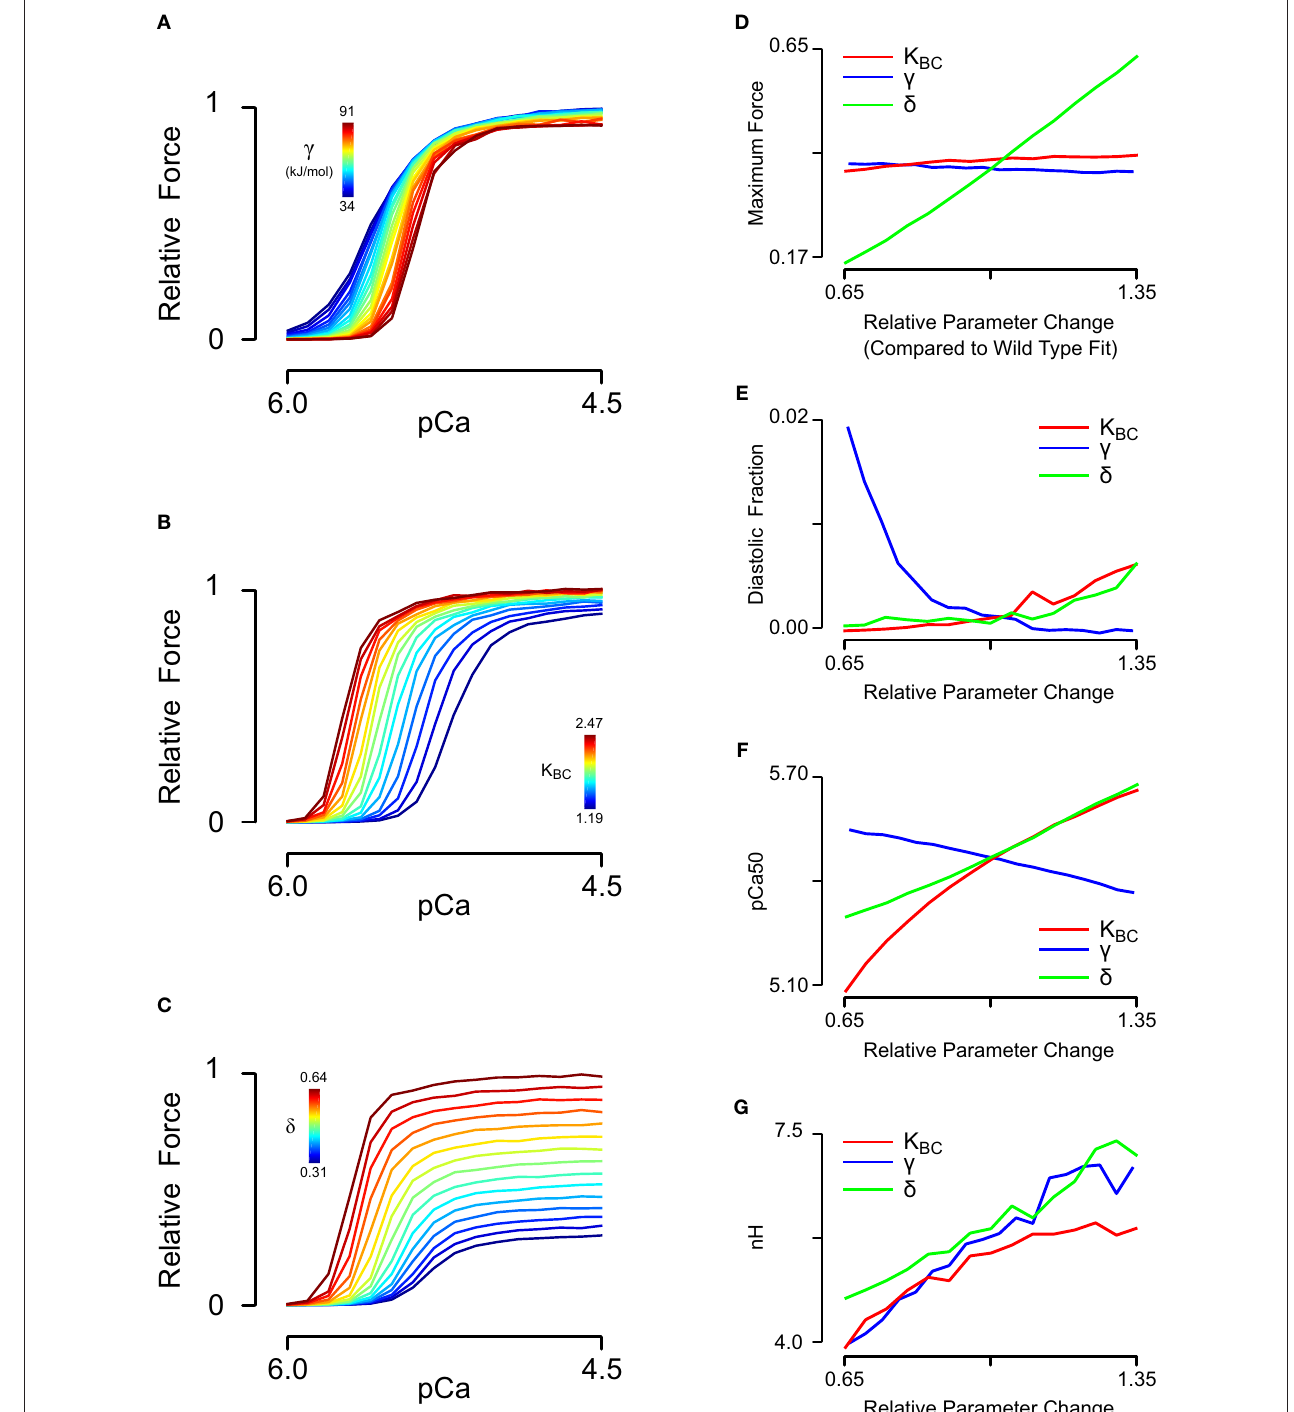
FIGURE 3 | Sensitivity analysis of steady-state force-pCa simulations. (A) Relative steady state force-pCa curves as a function of the tropomyosin stiffness varied from 50 to 135% of the original fit stiffness of 68e3. (B) Relative steady state force-pCa curves as a function of the BC equilibrium constant varied from 65 to 135% of the original fit BC equilibrium constant of 1.83. (C) Relative steady state force-pCa curves as a function of the duty cycle varied from 65 to 135% of the original fit duty cycle of 0.47. (D) The maximum steady state force production depended primarily on the myosin duty cycle while BC equilibrium and stiffness have minor effect. (E) The fraction of the maximum steady state force present at low calcium (pCa 6.0) was strongly shaped by the stiffness with a minor dependence on the BC equilibrium and duty cycle. (F) Whereas, increased BC equilibrium and duty cycle increase the pCa 50 , stiffness served to decrease the pCa 50 . (G) Cooperativity could be strongly tuned by variation in tropomyosins stiffness and myosin duty cycle whereas BC equilibrium could decrease cooperativity but could not increase it much above its steady state value.